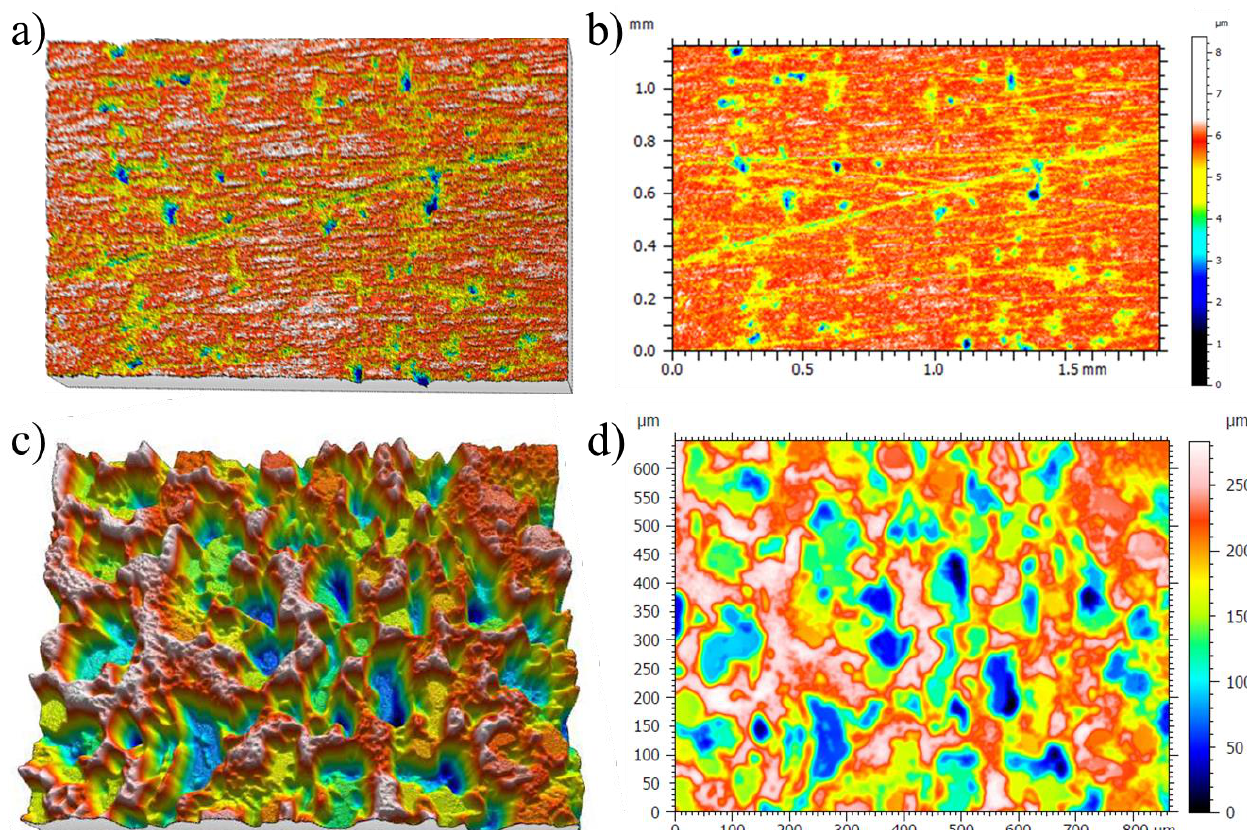
Figure 10. The 3D and 2D morphologies of the surface structures: ( a , b ) smooth plate (SP); ( c , d ) non-structured (NS) plate.